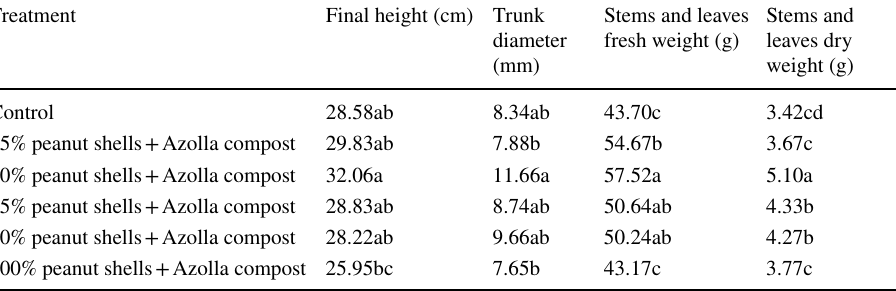
The means of the same letters do not significantly differ ( p ≤